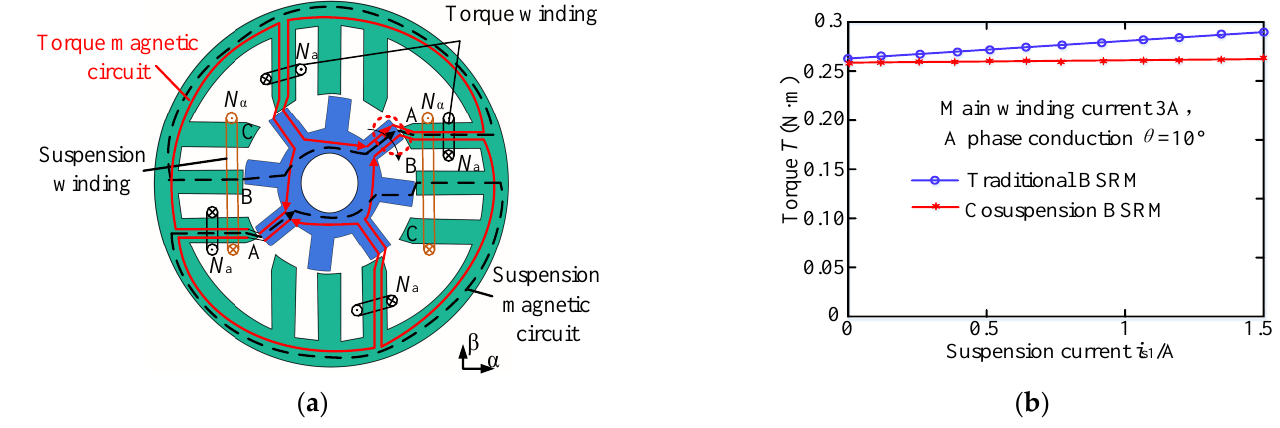
Figure 12. Co-suspension winding BSRM: ( a ) Motor structure; ( b ) Comparison of conventional BSRM torque and co-suspension BSRM torque.